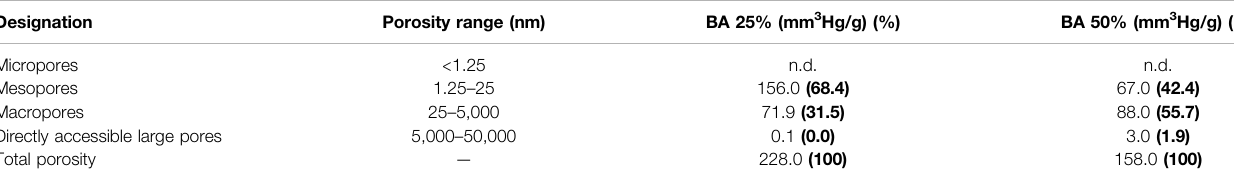
TABLE 3 | Classi fi cation of porosity in the investigated samples according to IUPAC.